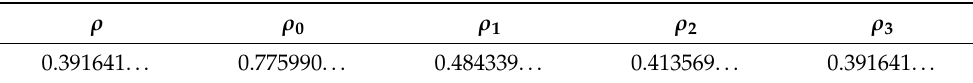
Table 6. Radius for Example